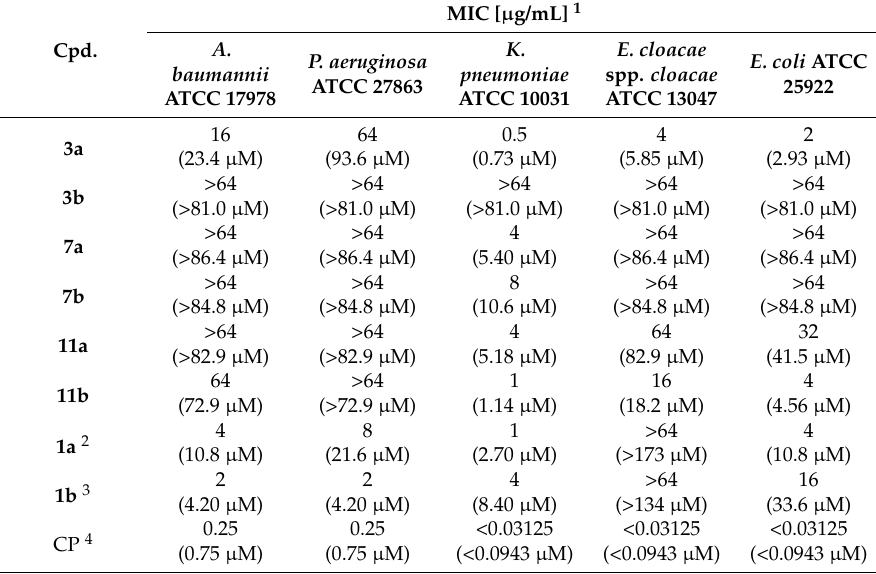
Table 2. Minimum inhibitory concentration (MIC) values of the new hybrid compounds against the indicated Gram-negative bacterial strains. Cpd.